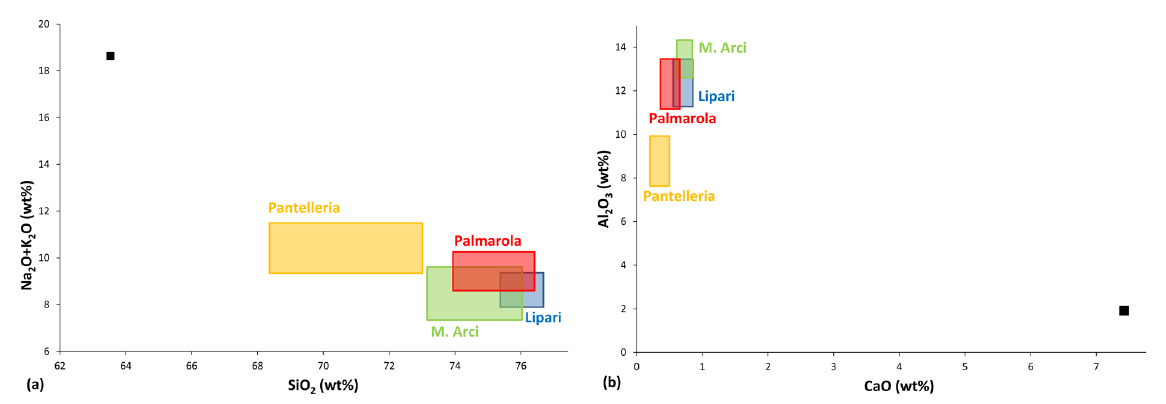
O+K O vs SiO (a), Al O vs CaO (b) and MnO vs Fe Figure 13: Na 2 2 2 2 3 compositional areas of obsidians from the pery-Tyrrenian area. SEM-EDS data for sample MT-OS1-O1 and chemical data of Lipari, M. Arci, Palmarola, and Pantelleria obisidians from (Acquafredda et al., 1999; De Francesco et al., 2008; Francaviglia, 1988; Le Bourdonnec et al., 2010; Tykot,